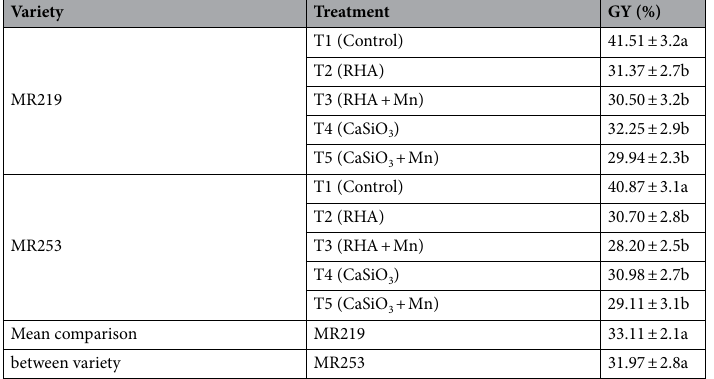
Table 5. Brown spot index (BSI) of MR219 and MR253 rice varieties cultivated under different treatment conditions. Treatment combinations are represented as following: T1 = control (standard fertilizer, NPK only), T2 = NPK + rice husk ash (RHA), T3 = NPK + RHA + manganese (Mn), T4 = NPK + calcium silicate (CaSiO 3 ), T5 = NPK + CaSiO